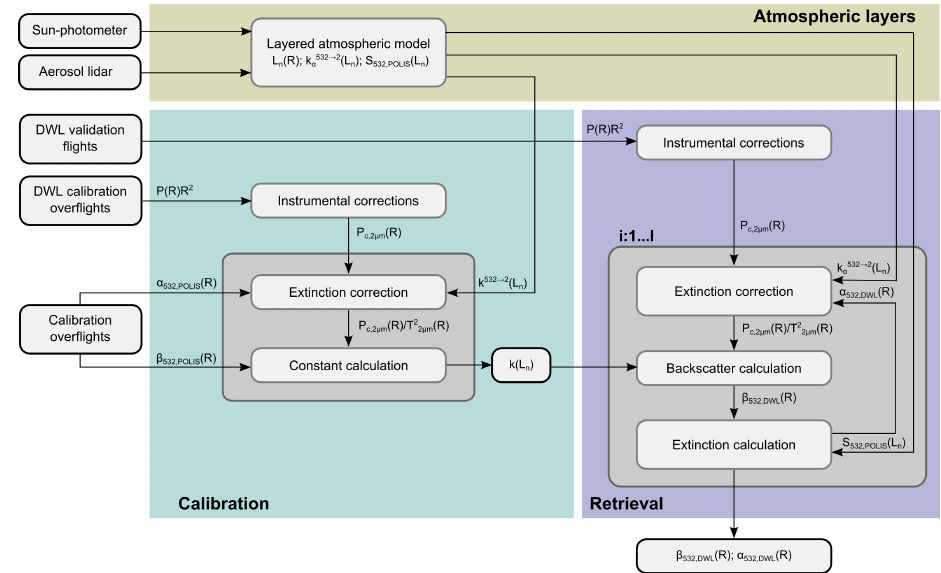
Figure 9. Overview of the calibration and retrieval procedure.